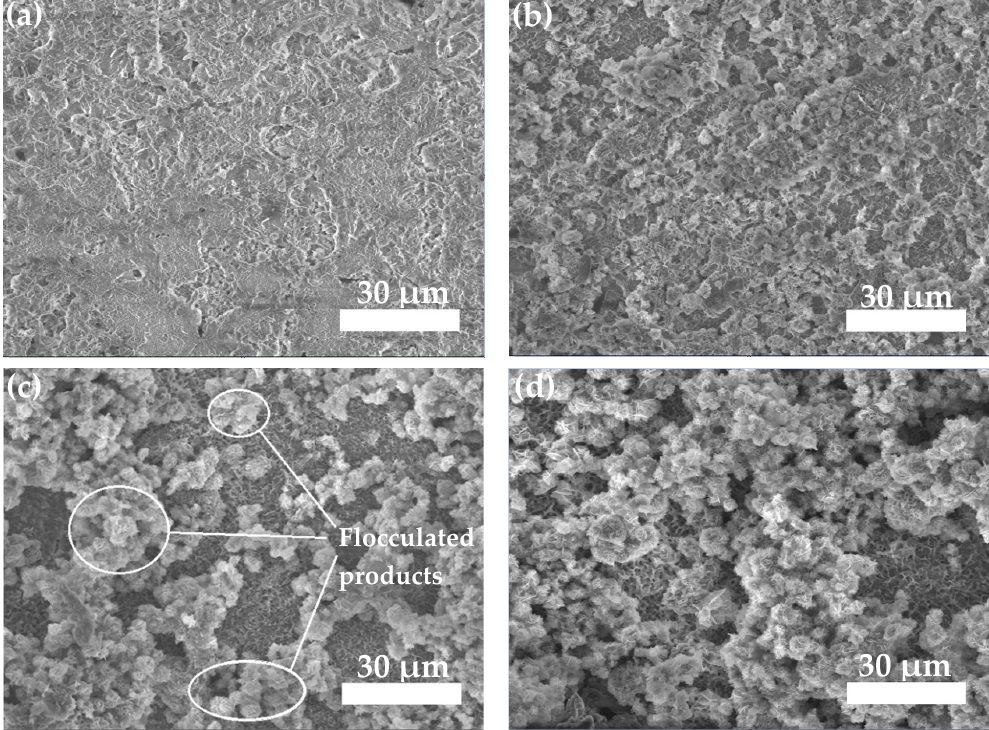
Figure 8. SEM micrographs for the Zn 45 Al 35 Mg 5 ZnO 15 coating after different conditioning periods: ( a )